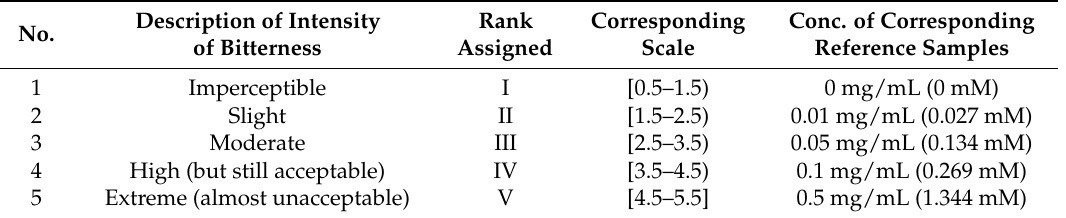
Table 1. Bitterness rank and concentration of corresponding reference samples.